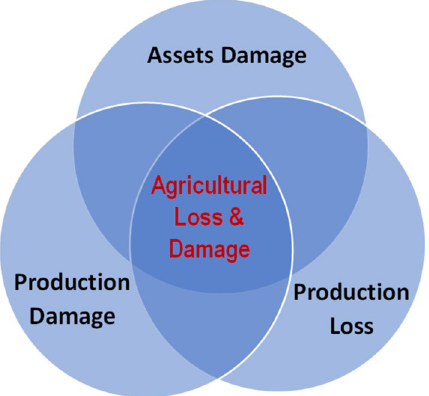
Figure 1. Key elements of agricultural Loss & Damage